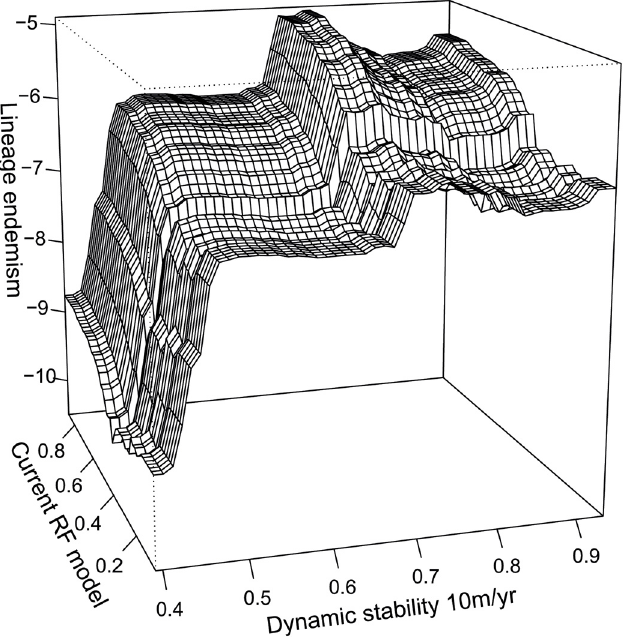
Fig 6. Influence of current rainforest and historical rainforest stability on lineage endemism as predicted by the boosted regression tree model. Values of two predictors are shown: current rainforest habitat suitability, and dynamic stability of that habitat. Other predictors are held to their means. Lineage endemism increases with current rainforest habitat suitability and dynamic stability, but endemism is low in historically unstable areas (dynamic stability < 0.45) regardless of their current